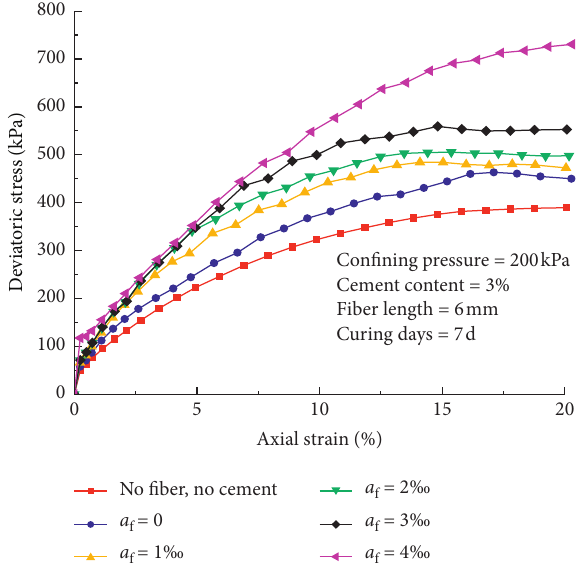
Figure 7: Effect of fiber content on deviatoric stress-axial strain